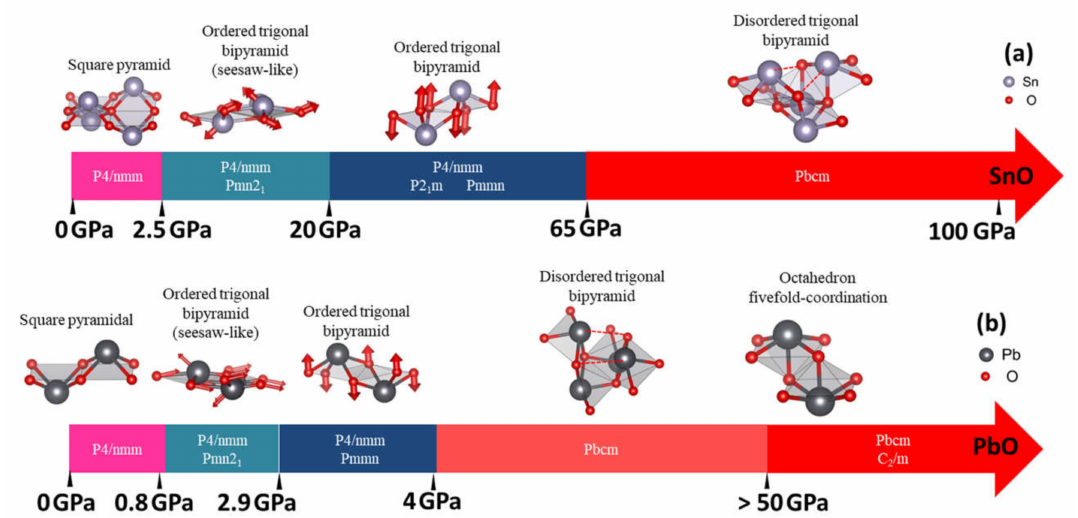
Figure 10. Summary of the structural evolution in pressure-induced transitions of SnO/PbO. The red arrows indicate the shifted position of the Sn/Pb and O atoms in ordered trigonal pyramidal arrangements compared to the square pyramidal arrangement. The enthalpy differences in pressure ranges with multiple phases are insignificant (less than 5 meV) between the phases: ( a ) The structural evolution in pressure-induced transitions of SnO; ( b ) The structural evolution in pressure-induced transitions of